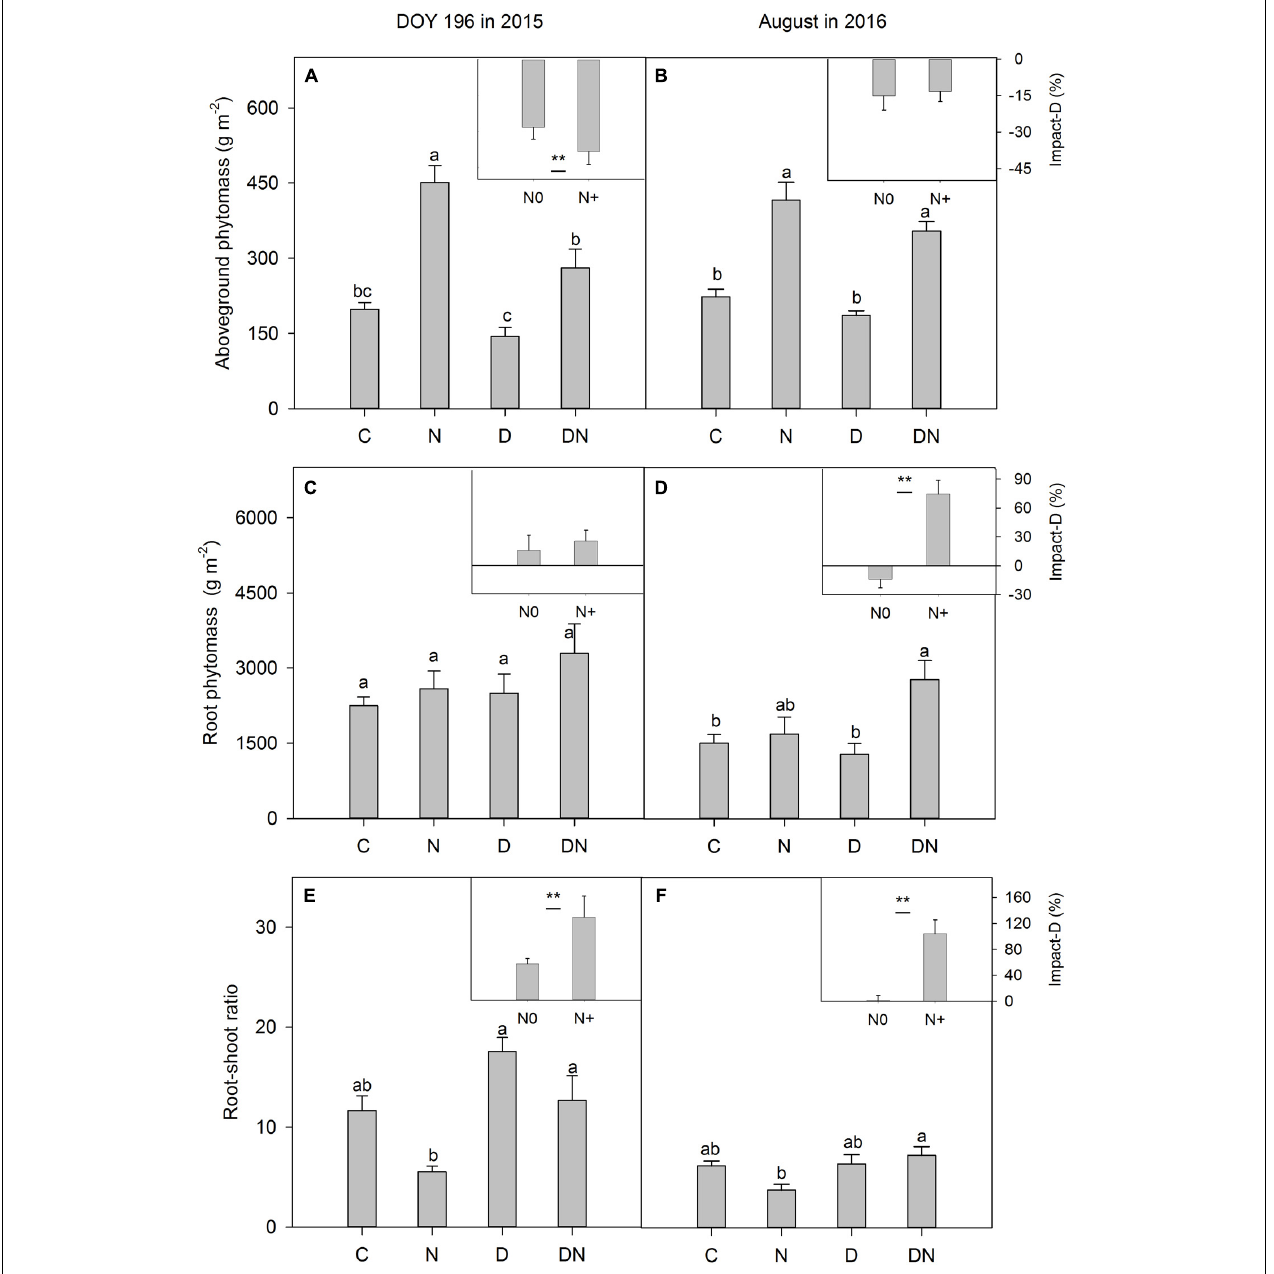
FIGURE 6 | Responses of (A,B) aboveground phytomass, (C,D) root phytomass and (E,F) root-shoot ratio to four treatments (C, control; N, nitrogen addition; D, drought; DN, nitrogen addition plus drought) at the end of the drought period (DOY 196 in 2015) and 1 year after the drought event (August in 2016). Impact-D = ( X D – X C )/ X C × 100, or = ( X DN – X N )/ X N × 100, where X indicates aboveground phytomass, root phytomass or root-shoot ratio. Different letters and asterisk indicate significant differences between the treatments ( P < 0.05). The error bars represent standard errors of means ( n =